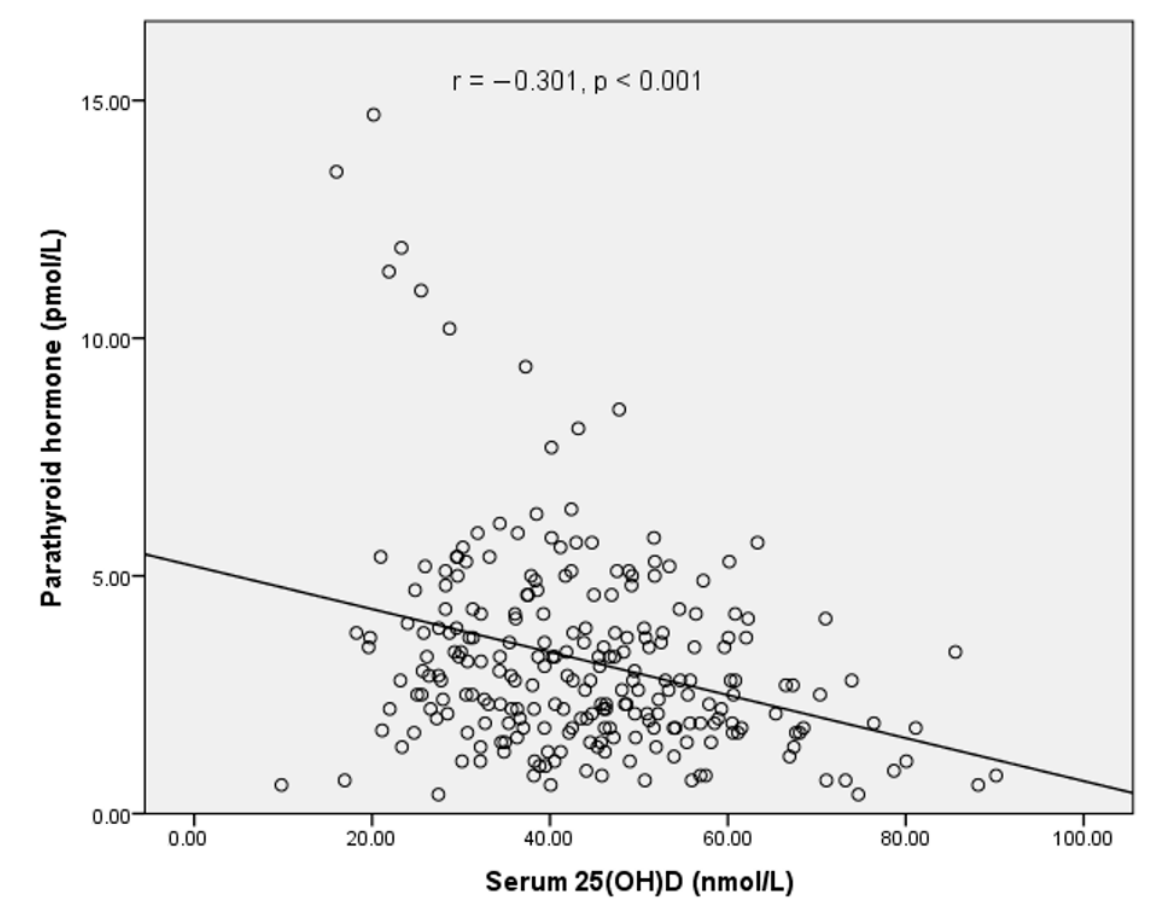
Figure 1. Relationship between iPTH and serum 25(OH)D concentration.